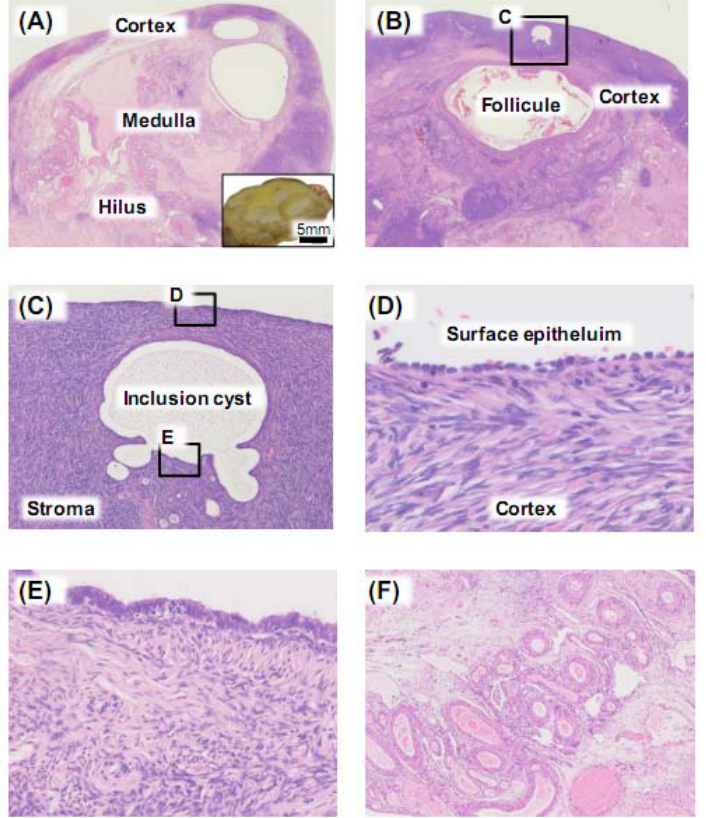
Figure 1. Macroscopic and microscopic features of the ovary. ( A ) Cut surface of the ovary. Cortex, medulla and hilus are distinguishable; ( B ) Intermediate magnification of cortex area; Rectangle ( C ) contains an inclusion cyst; ( C ) High magnification of cortex area indicated by rectangle in ( B ); Inclusion cysts are surrounded by dense fibrotic stroma; ( D ) High magnification of ovarian surface. Thin columnar surface epithelial cells are lined; ( E ) High magnification of an inclusion cyst. Tall columnar epithelial cells are lined; ( F ) High magnification of hilus area. Numerous vessels are